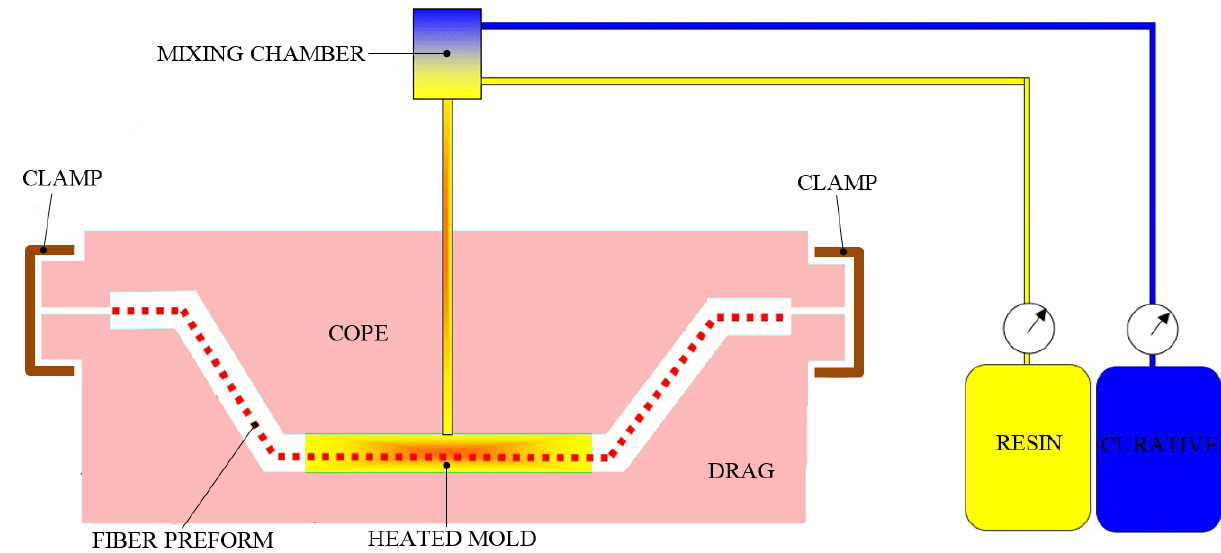
Figure 8. An illustration of the resin transfer molding process for production of FRP